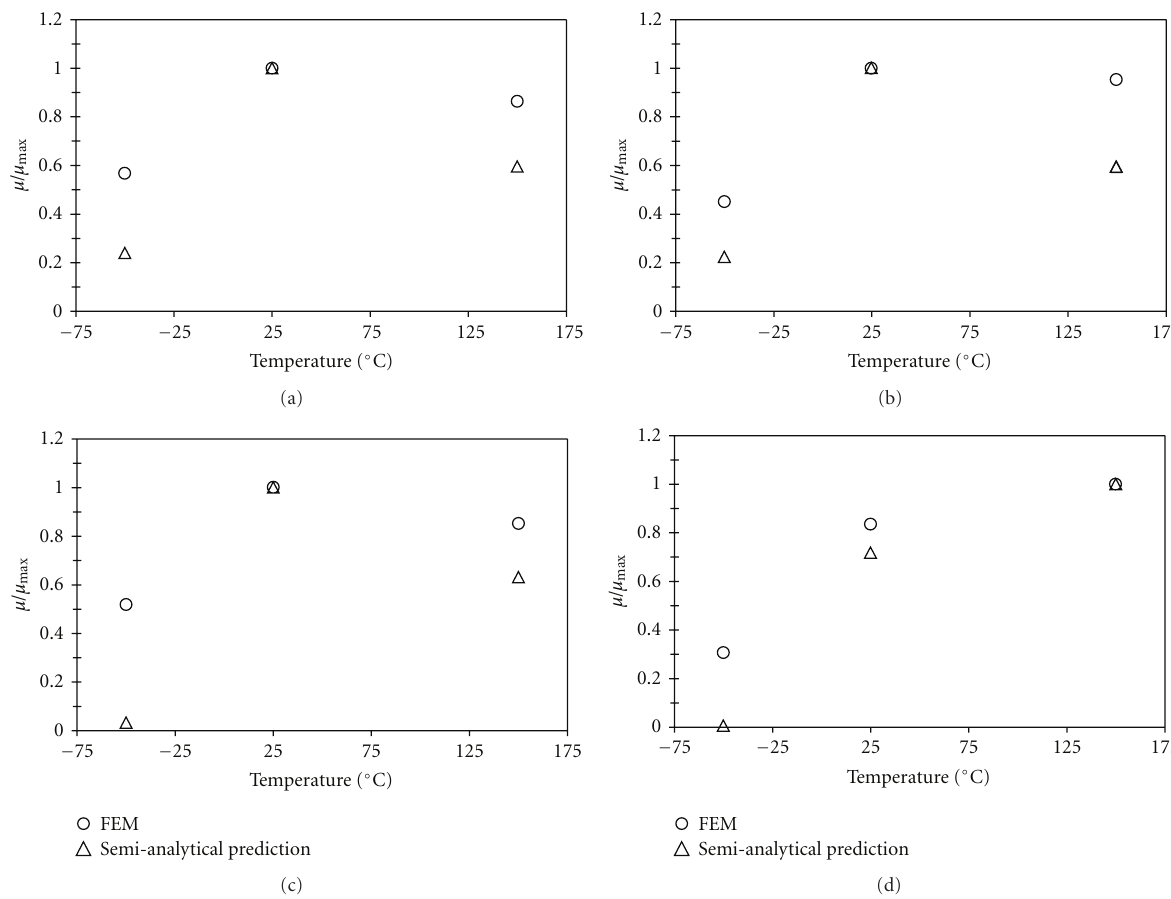
Figure 12: COFs normalized by the highest COF in case of FEM and semi-analytical prediction, (a) 40-term Generalized Maxwell model = 0 . 044, μ 0 = 1 . 1 E − 3. (b) 40-term Generalized Maxwell model fitted to the storage fitted to the storage modulus, countersurfaces A: μ Force max max = 0 . 062, μ 0 = 3 . 5 E − 3. (c) 40-term Generalized Maxwell model fitted to the loss factor, countersurfaces modulus, countersurfaces B: μ Force max max = 0 . 054, μ 0 = 2 . 9 E − 3. (d) 40-term Generalized Maxwell model fitted to the loss factor, countersurfaces B: μ Force A: μ Force max max μ 0 = 1 . 6 E − max